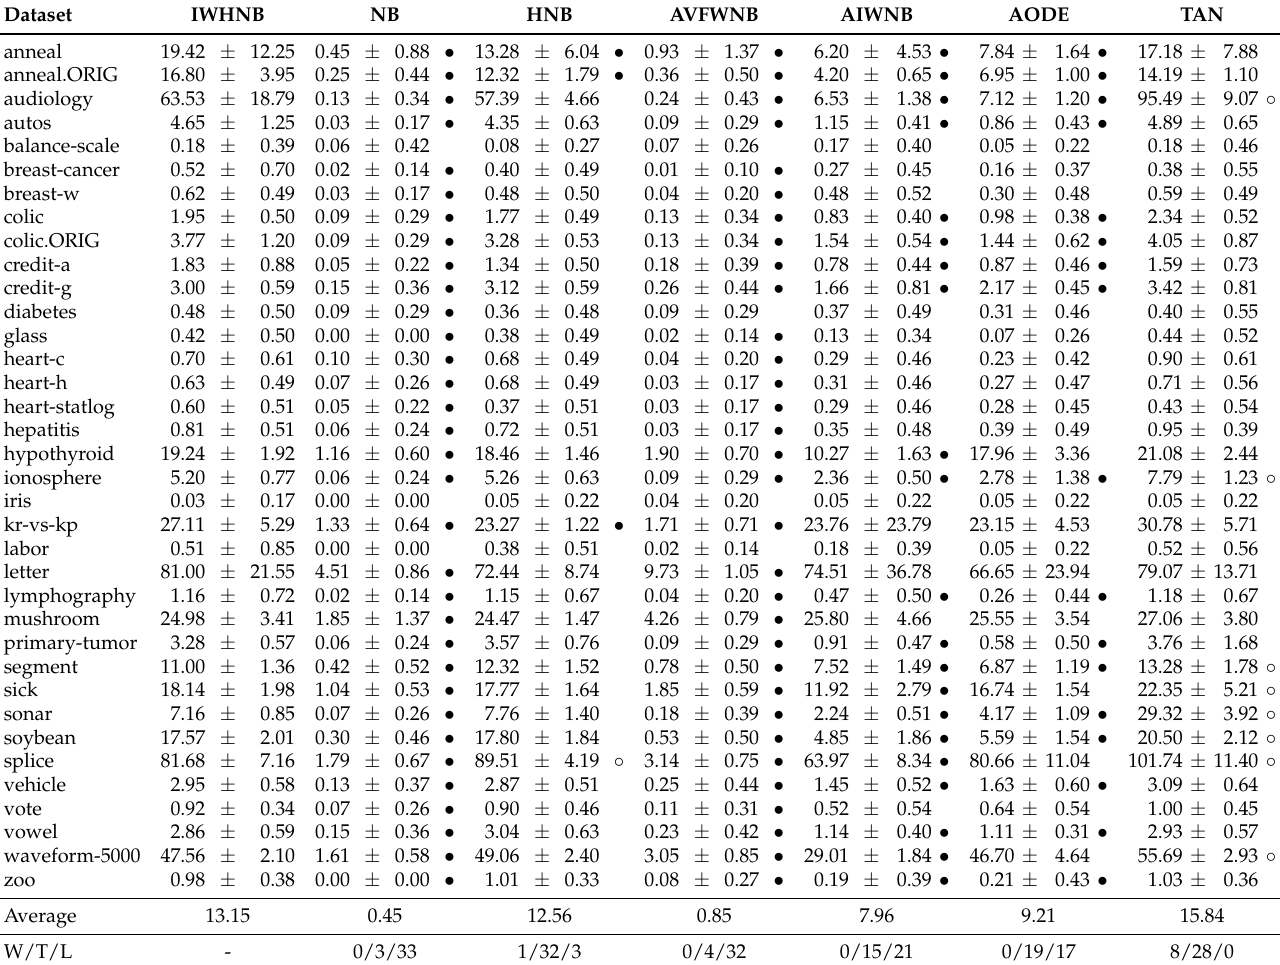
Table 4. Comparisons of the elapsed training time for IWHNB versus NB, HNB, AVFWNB, AIWNB, AODE and TAN. Dataset IWHNB anneal